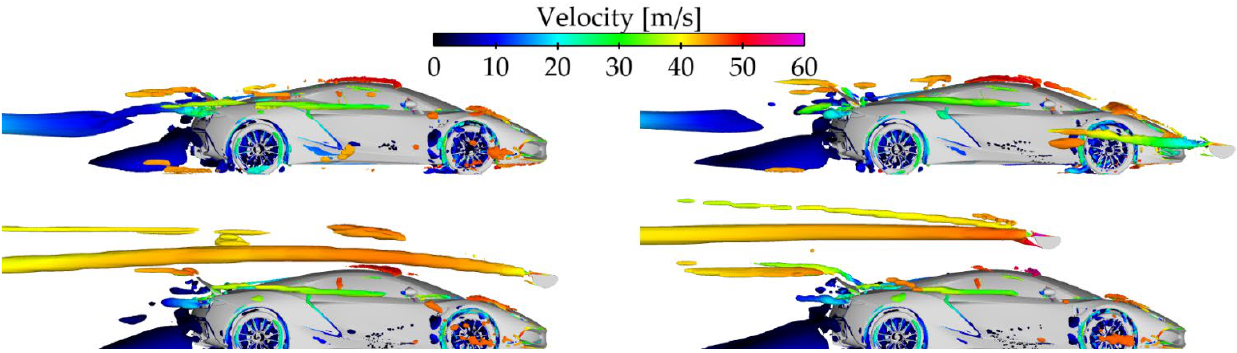
Figure 34. Distributions of the normalized Q = 0.05 parameter around the vehicle without a front wing and for the vehicle with three different wing positions, influenced by the velocity magnitude (side view).